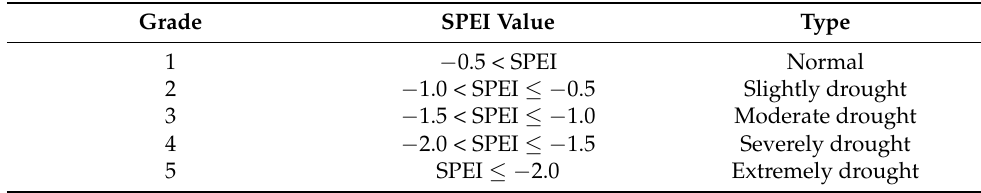
Table 3. Meteorological Drought